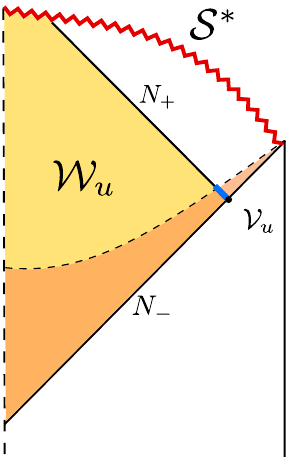
Figure 4 . Maximally extended FLRW solution embedded in AdS space. The early-times approxi- mation a (~ t ) (cid:25) ~ t guarantees that the geometry in the vecinity of N (cid:0) (shaded region) is the same as in the pure AdS solutions, implying that I (cid:0) the same is true for the near-horizon piece of I + cancelled provided no new dominating contributions arise from the deep interior piece of I +